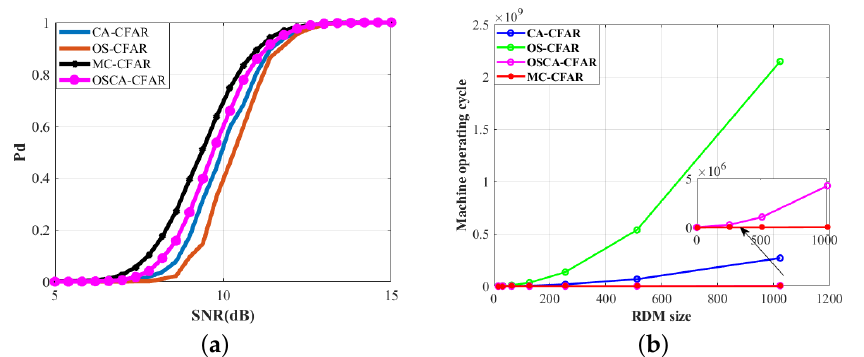
Figure 15. MC-CFAR algorithm performance. ( a ) Detection sensitivity. ( b ) Computational complexity.